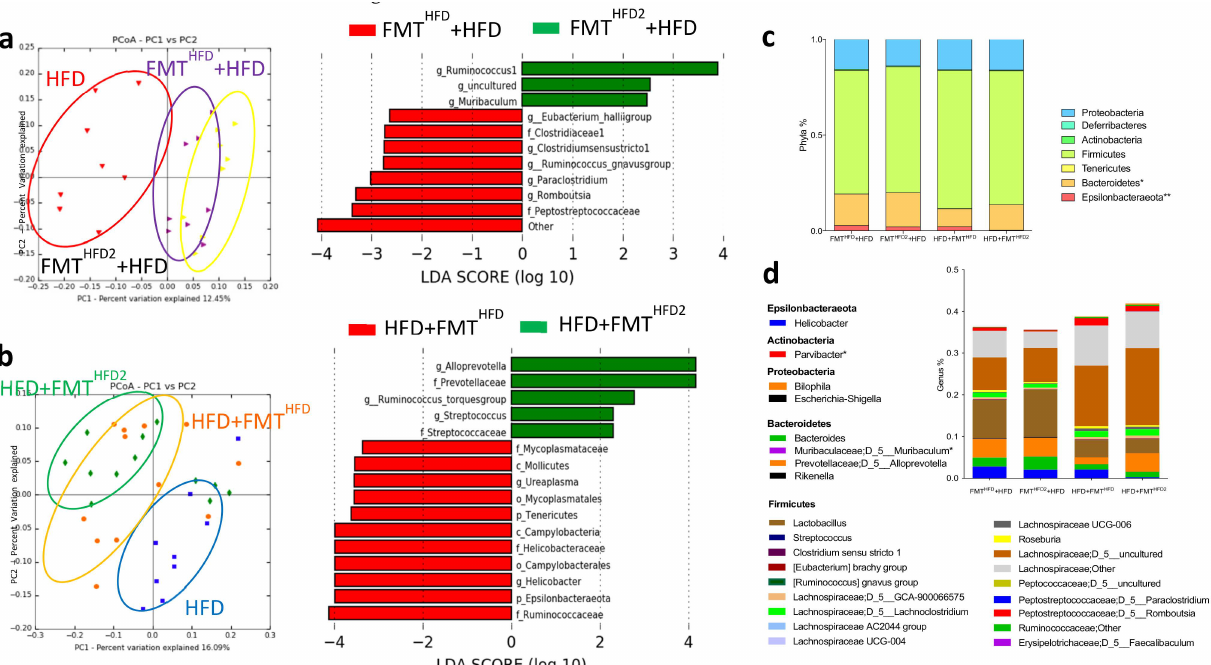
Figure 6. Curative and preventive FMT induce modifications of IM composition. Mice received a preventive FMT before 16 weeks of HFD from donor mice fed an HFD (FMT HFD + HFD) or donor mice fed an HFD2 (FMT HFD2 + HFD). Obese mice received a curative FMT before eight supplementary weeks of HFD from donor mice fed an HFD (HFD + FMT HFD ) or donor mice fed an HFD 2 (HFD + FMT HFD2 ): ( a ) unweighted Unifrac distances showing differences in IM composition between the groups: red = HFD (4 months of diet), yellow = FMT HFD2 + HFD, purple = FMT HFD + HFD ( p = 0.01) (left panel), and LDA effect size (LEfSe) for the taxa enriched in FMT HFD + HFD (red) or FMT HFD2 + HFD (green) mice (right panel). Only taxa with a LDA score >2 and p < 0.05, determined by the Wilcoxon signed rank test, are shown. ( b ) Unweighted Unifrac distances showing differences in IM composition between the groups: blue = HFD (6 months of diet), green = HFD + FMT HFD2 , orange = HFD + FMT HFD ; ( p = 0.08) (left panel) and LDA Effect Size (LEfSe) for the taxa enriched in HFD + FMT HFD (red) or HFD + FMT HFD2 (green) mice (right panel). Only taxa with a LDA score >2 and p < 0.05, determined by the Wilcoxon signed rank test, are shown. ( c ) Relative abundance of bacteria at the phyla and ( d ) genus level. Data represent the mean ± SEM of 9 or 12 mice. * p < 0.05, ** p <